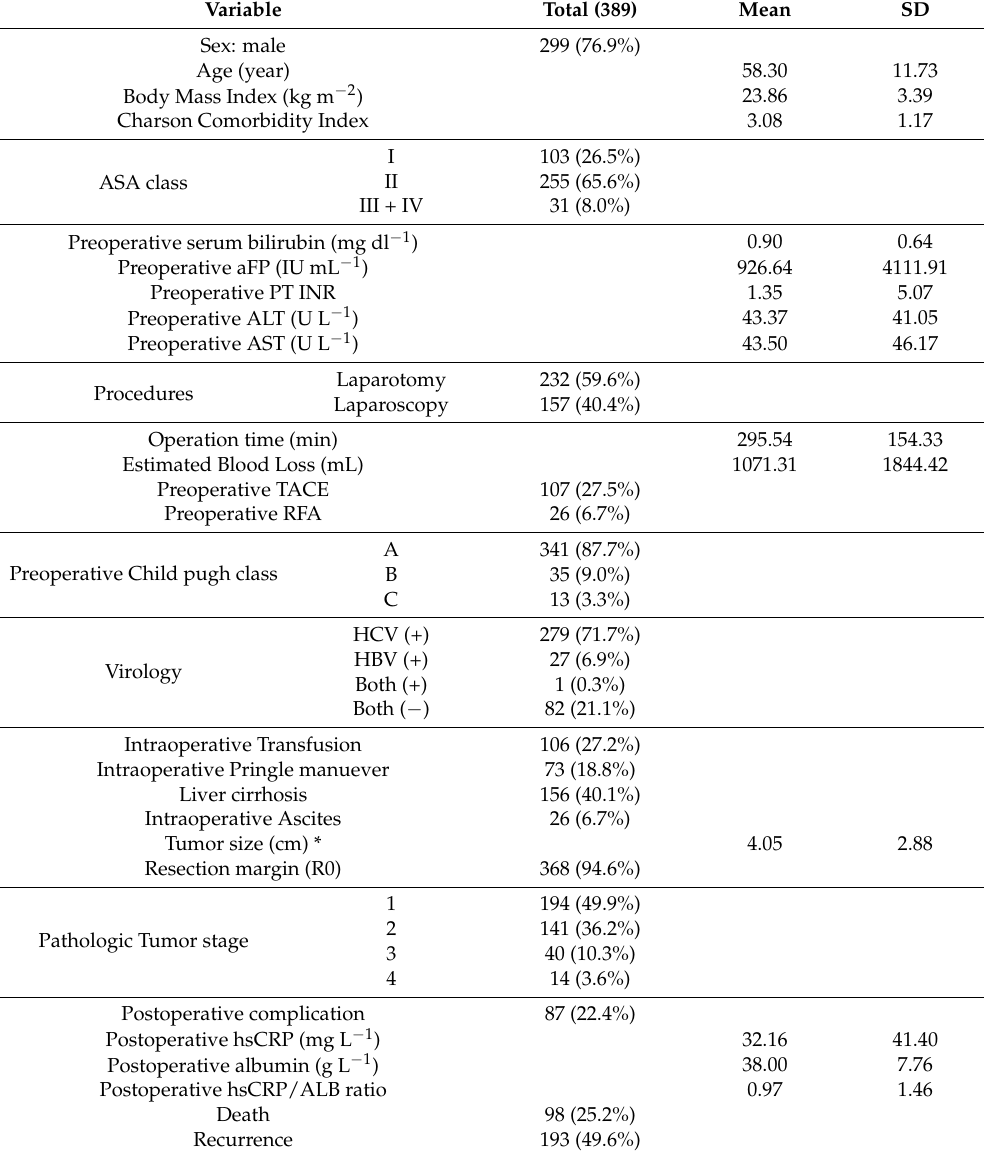
Table 1. Baseline